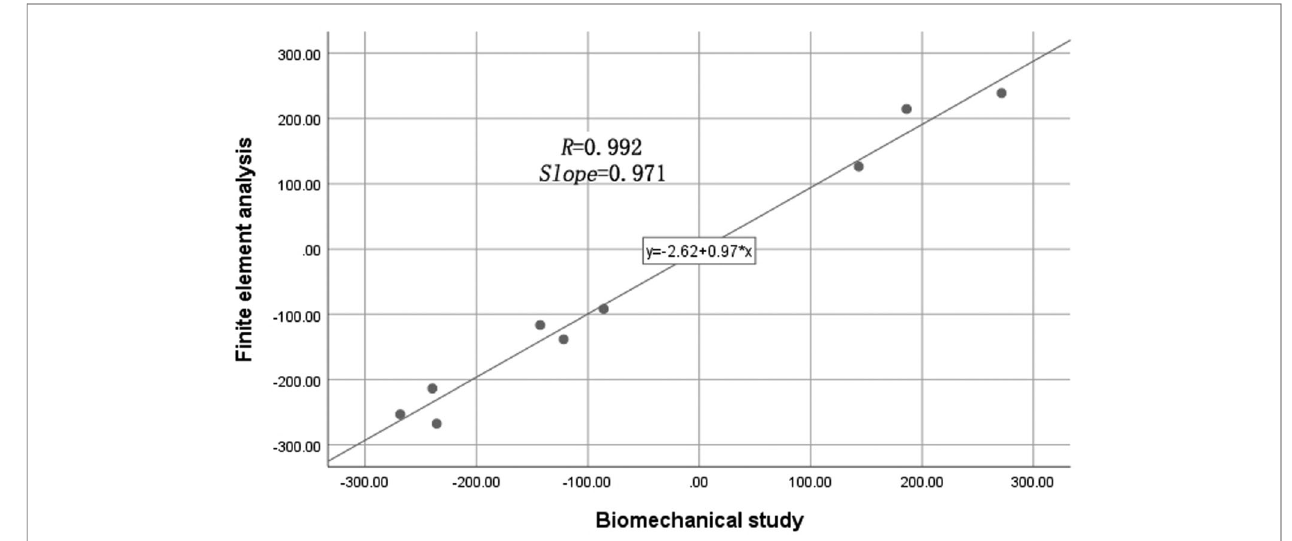
FIGURE 6 | Recording the strain value of marker points in the biomechanical study and fi nite-element analysis.